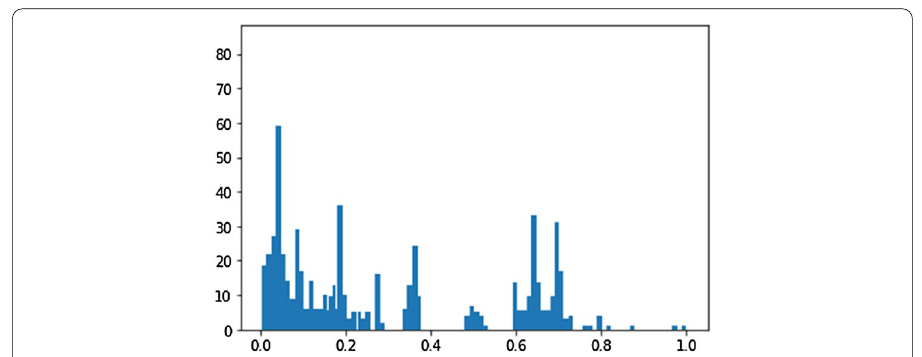
Fig. 6 ICA—Number of instances vs reconstruction error value for noisy data points